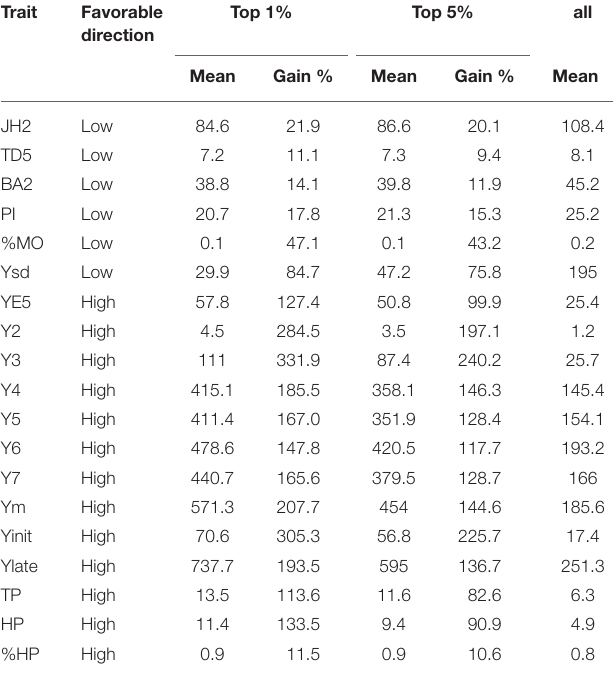
TABLE 2 | Narrow-sense heritability ( h 2 ) and dominance ratio ( d 2 ) for evaluated traits calculated from the single-trait analysis. Trait